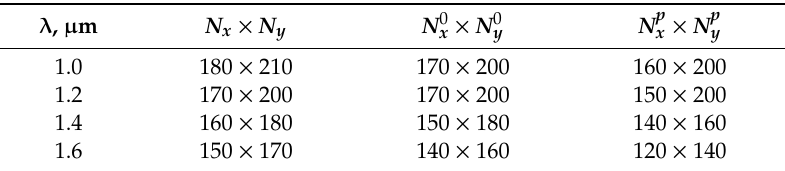
Table 1. AOTF imager